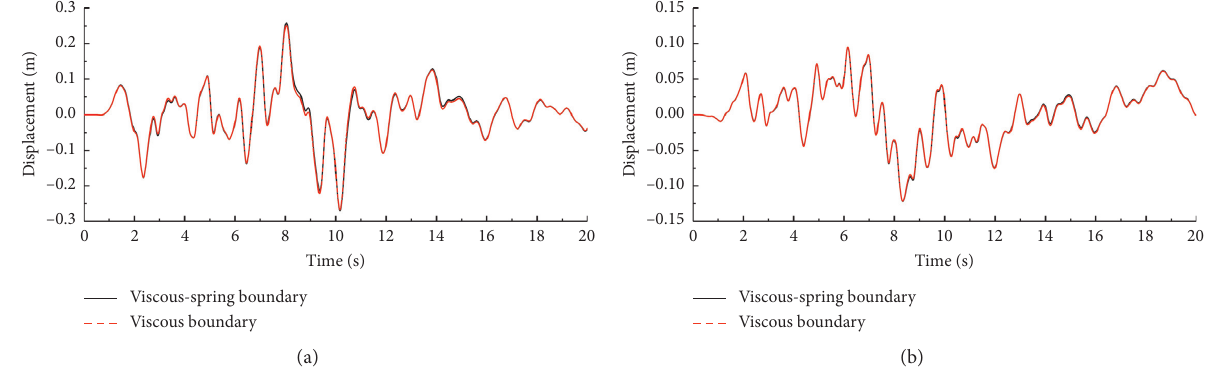
Figure 16: Time histories of (a) horizontal and (b) vertical displacements at dam crest.